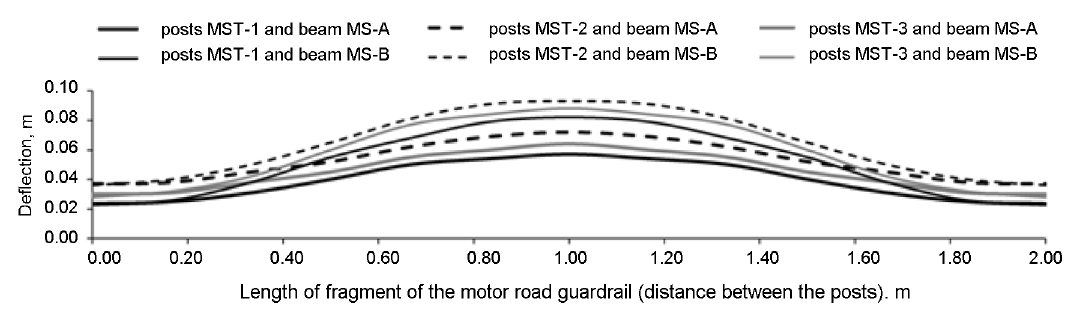
Fig. 15. The comparison of deflections of guardrails mounted on bridges or viaducts (our